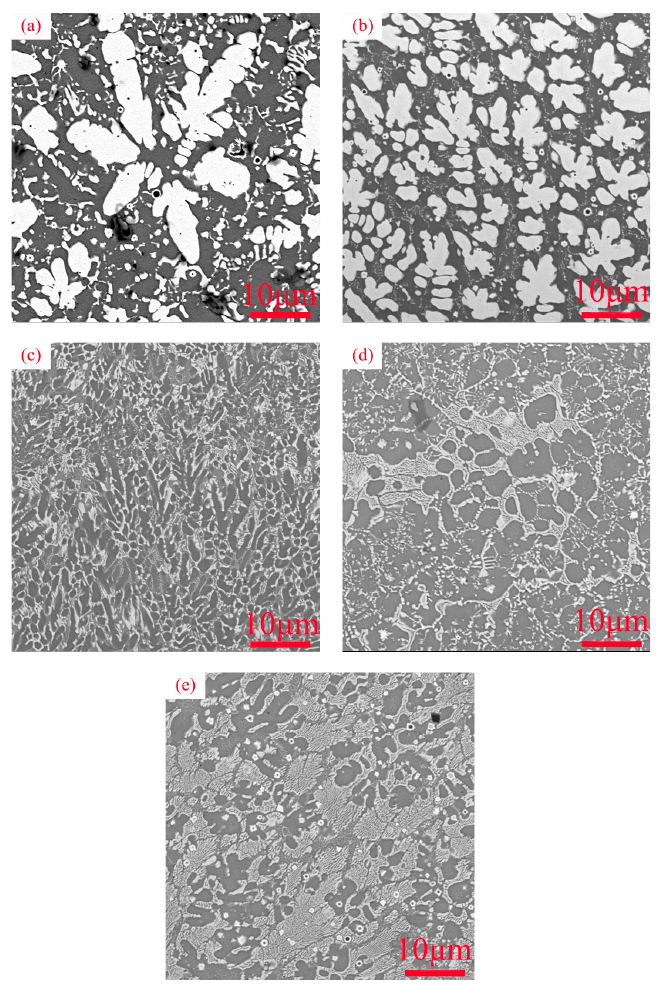
Figure 2. SEM of the cross-section of WVTaTiCr x refractory high-entropy alloy coating: ( a ) Cr 0 ; ( b ) Cr 0.25 ; ( c ) Cr 0.5 ; ( d ) Cr 0.75 ; ( e ) Cr 1